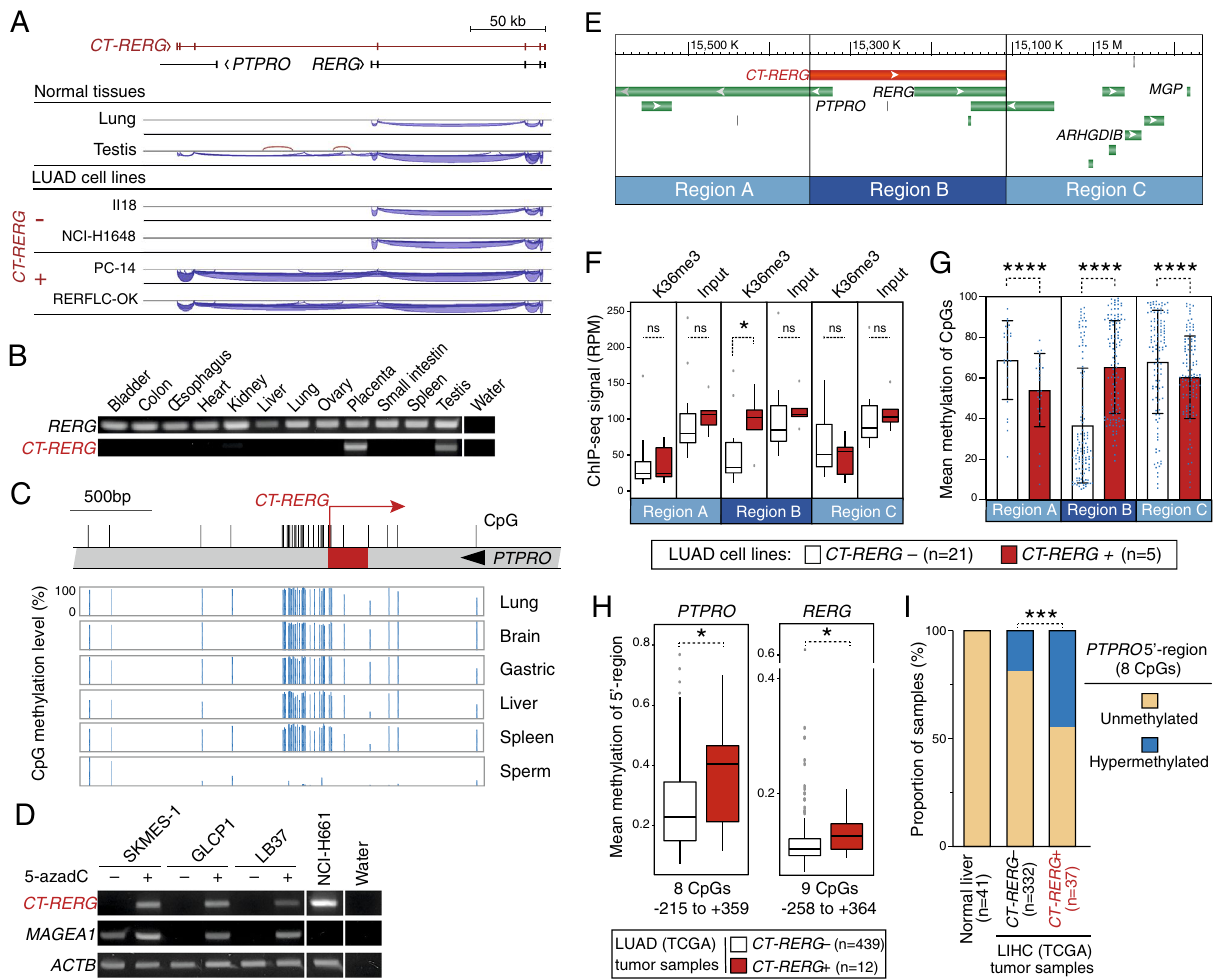
Figure 6. DNA hypomethylation-induced transcriptional overlap is associated with DNA hypermethylation of PTPRO and RERG tumor suppressor genes. ( A ) RNA-seq data from indicated samples were analyzed with IGV. Exon–intron structures are depicted on the top. ( B ) RT-PCR analyses in various normal tissues were performed with primers specific for either RERG or CT-RERG transcripts. ( C ) Bisulfite-seq data (NIH Roadmap epigenomics) revealing the methylation level (histograms) of CpG sites (vertical bars) surrounding the CT-RERG transcription start (broken arrow) in normal tissues. ( D ) CT-RERG -negative lung tumor cell lines were cultured with (−) or without (+) the DNA methylation inhibitor 5-azadC, and RT-PCR experiments were performed to test induction of CT-RERG mRNA. NCI-H661 lung tumor cell line was used as a positive control of CT-RERG expression. ACTB served as an internal control, and MAGEA1 as a control of 5-azadC induction. ( E ) Three 240 kb genomic regions were defined for subsequent analyses: CT-RERG transcription unit ( B ) and the two neighboring segments ( A and C ). ( F ) Mean amounts of ChIP-seq reads for H3K36me3 or control input in genomic regions A, B and C were compared in LUAD cell lines that do or do not express CT-RERG . *Mann– Whitney test, p -value < 0.05. ( G ) Mean methylation levels (%, Methyl-seq data) of all CpGs contained in each of the three genomic regions were compared in CT-RERG -positive and -negative LUAD cell lines. ****Mann– Whitney test, p -value ≤ 0.0001. ( H ) Mean methylation levels of all CpG sites embedded within the 5 ′ region of either the PTPRO (n = 8, − 215 to + 359 relative to TSS) or RERG (n = 9, − 258 to + 364) were compared in CT-RERG - and CT-RERG + LUAD tumor samples (TCGA). *Mann–Whitney test, p -value < 0.05. ( I ) The proportion of samples with PTPRO hypermethylation was determined in TCGA samples of hepatocellular carcinoma (LIHC, n = 369) grouped according to the CT-RERG expression status. Considering that the mean CpG methylation values within the PTPRO 5 ′ -region was 0.08 (SD ± 0.014) in normal liver tissues (n = 41), the region was considered hypermethylated in tumor samples where the mean CpG methylation value was > 0.2. ***Fisher’s exact test, p -value <